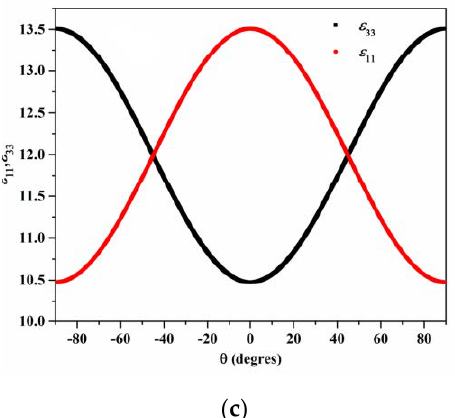
Figure 4. ( a ) Elastic constants, ( b ) piezoelectric coefficient, and ( c ) dielectric constants in (10 − 11 F/m) of tilted w-Sc 0.375 Al 0.625 N .